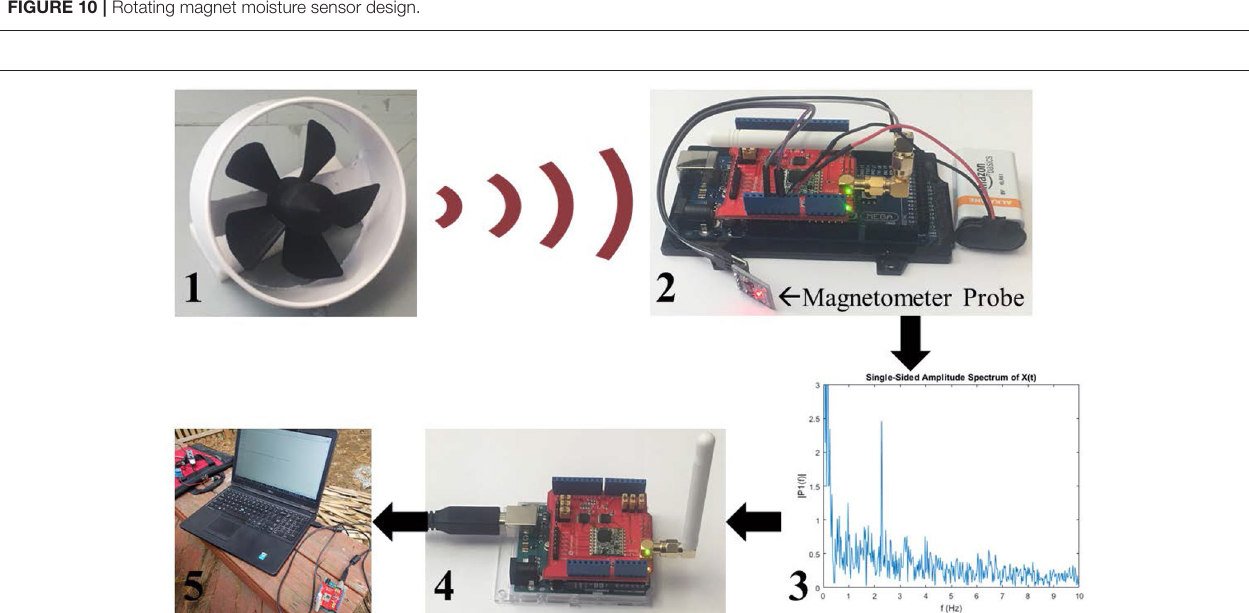
FIGURE 11 | Complete IoT magnetic telemetry